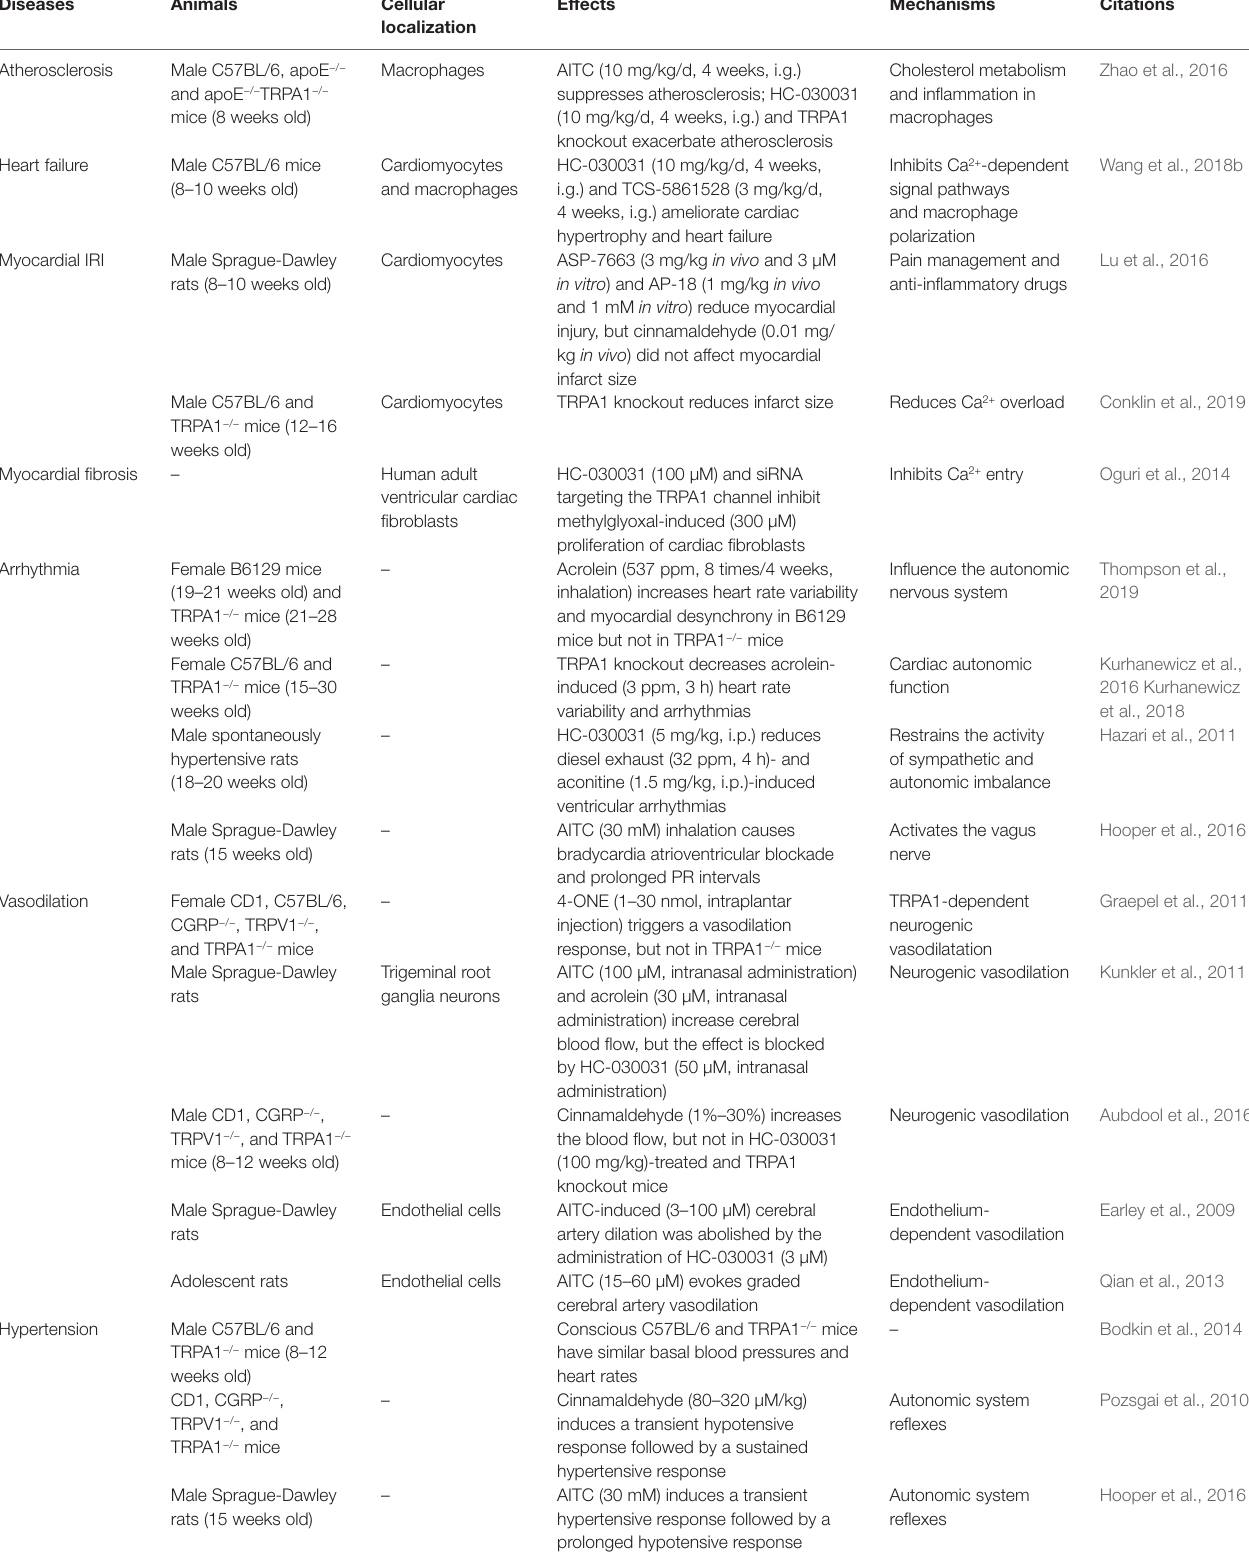
TABLE 3 | Role of the TRPA1 channel in the cardiovascular